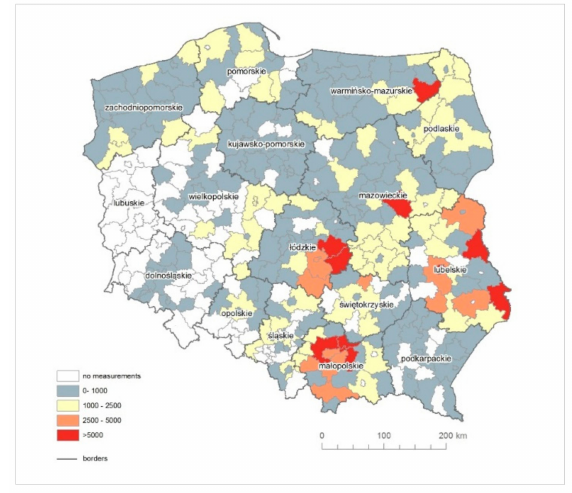
Figure 6. The measurements of the asbestos fibre concentrations in the air by